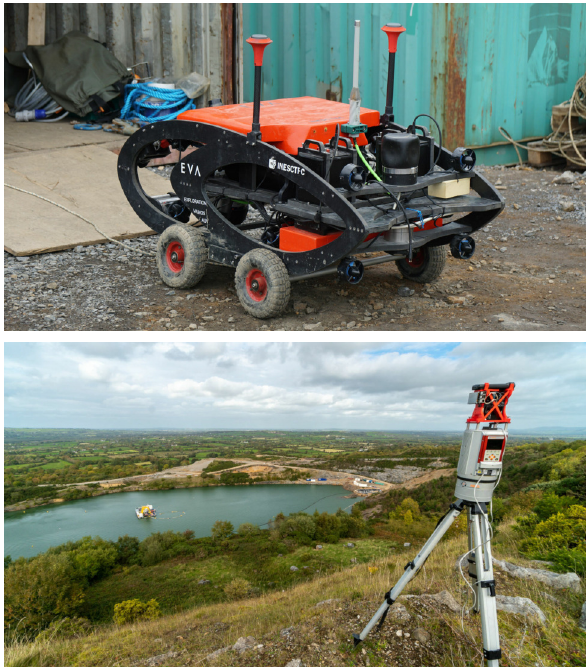
Figure 4. Equipment used for the above-the-water and underwater survey of the mine site. Top: the EVA AUV/HROV used for the multibeam sonar survey of the mine, bottom: survey of the Silvermines mine site using terrestrial